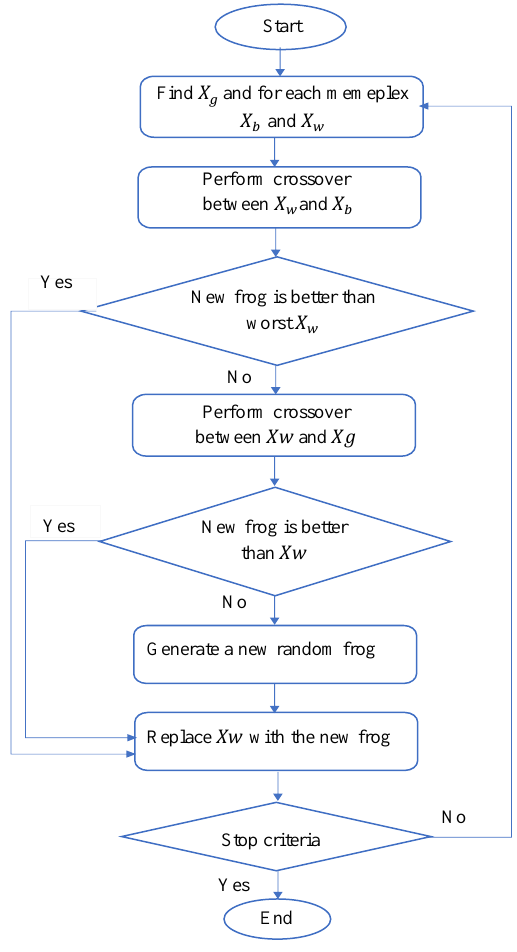
Figure 2. Flowchart of Local